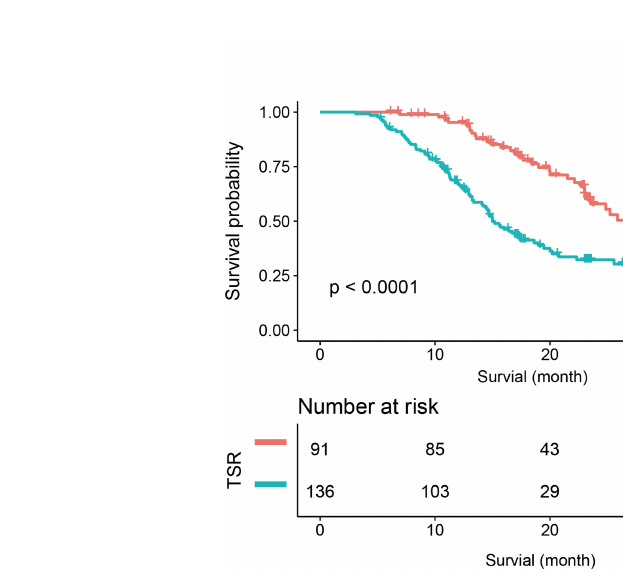
FIGURE 3 | The Kaplan-Meier curve and log-rank test. Patients in the tumor-stroma ratio (TSR)-low group had signi fi cantly longer survival than those in the TSR-high group.